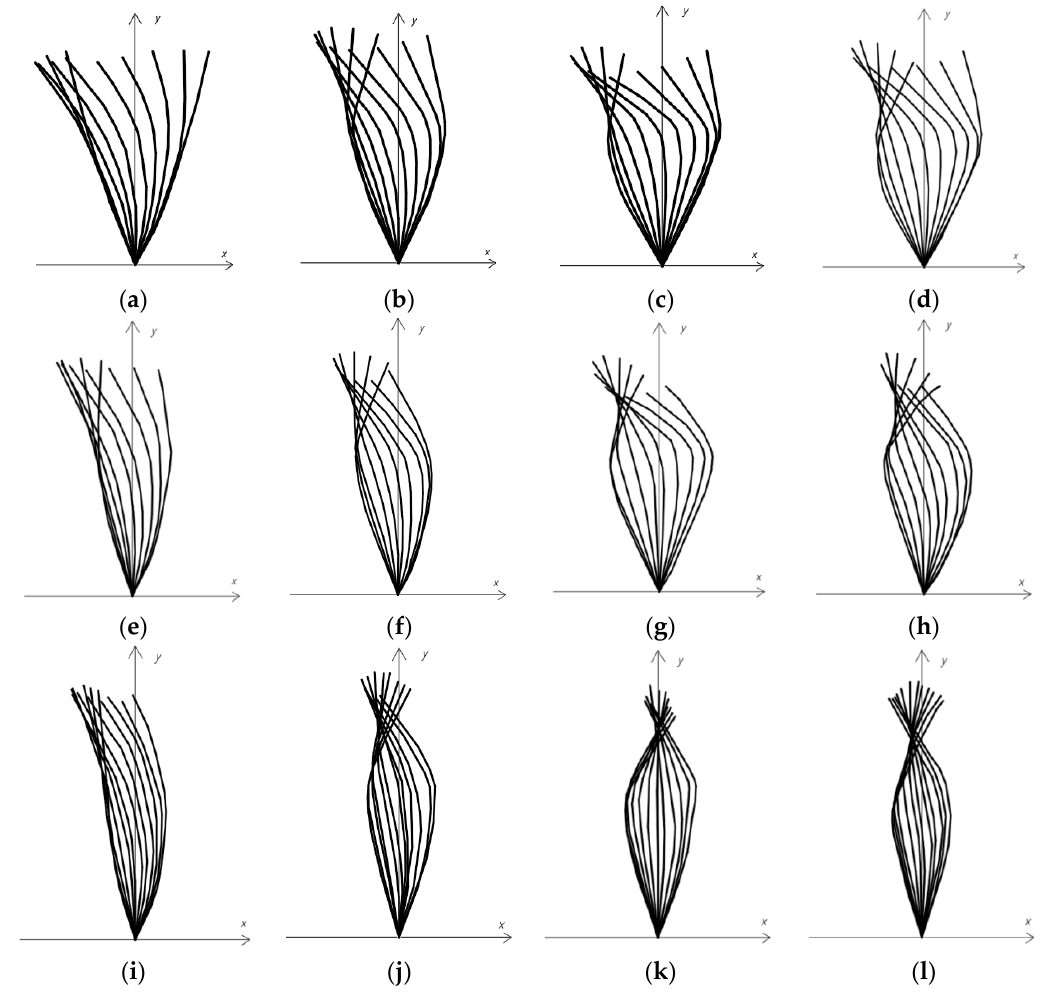
Figure 10. Under the conditions of 0.5 Hz, 0.8 Hz, and 1.2 Hz, we found that the curve of different conversion rates was the same as the curve of fish tail end stiffnesses of 0.03584. From left to right, there were the 1 degree function line, 2 degree function line, 3 degree function line, and 4 degree function line. ( a – d ) 0.5 Hz; ( e – h ) 0.8 Hz; ( i – l ) 1.2 Hz.